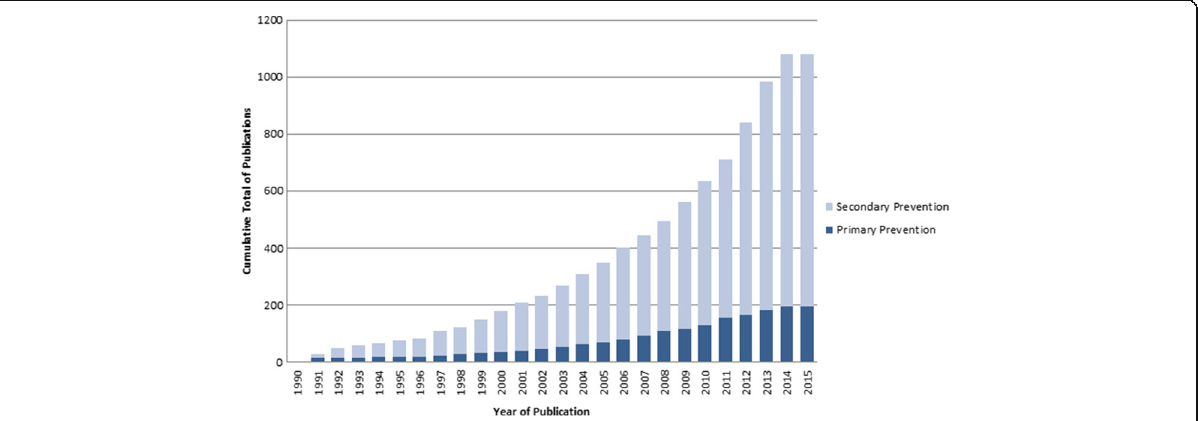
Fig. 2 Cumulative growth in published CPM articles included in the Tufts CPM database over time (January 1990 – March 2015). Dark blue represents models derived on CVD-free population samples. Light blue represents models derived on patients with specific cardiovascular conditions at baseline